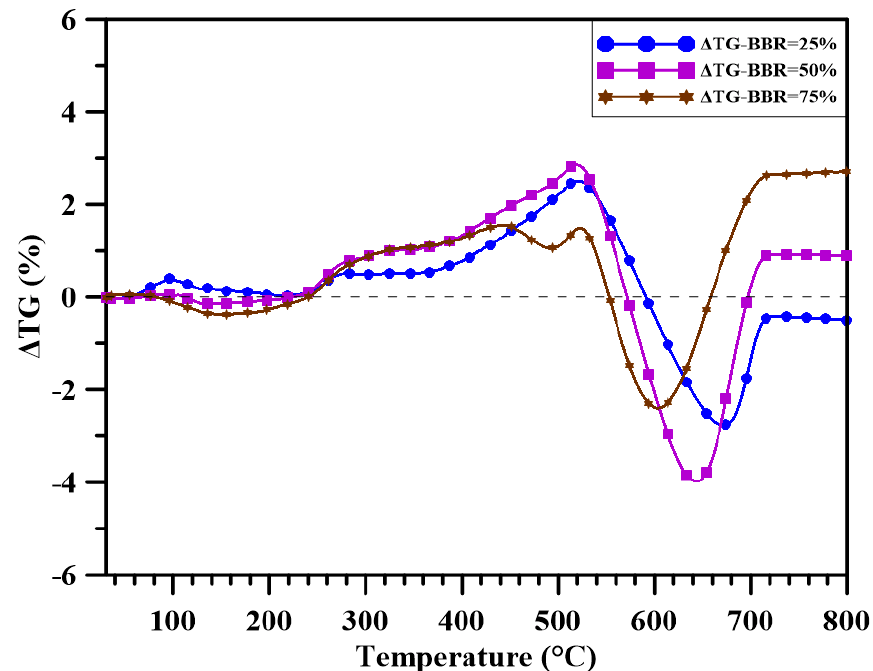
Figure 8. Degree of synergistic effect for various sludge-coal ratios.